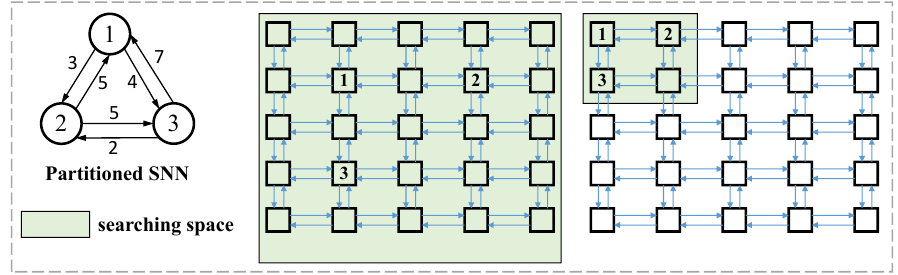
Figure 9. Different searching space in the mapping